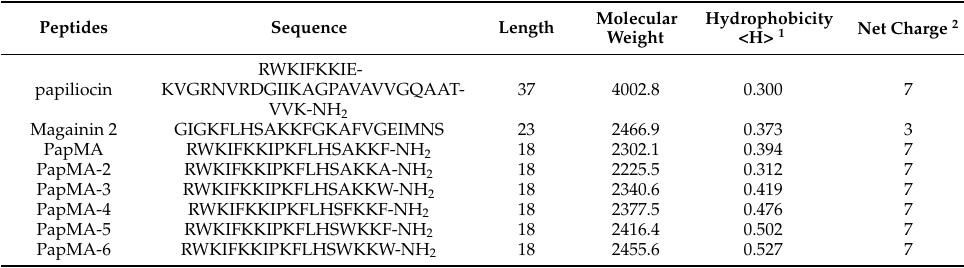
Table 1. Peptides and their physicochemical